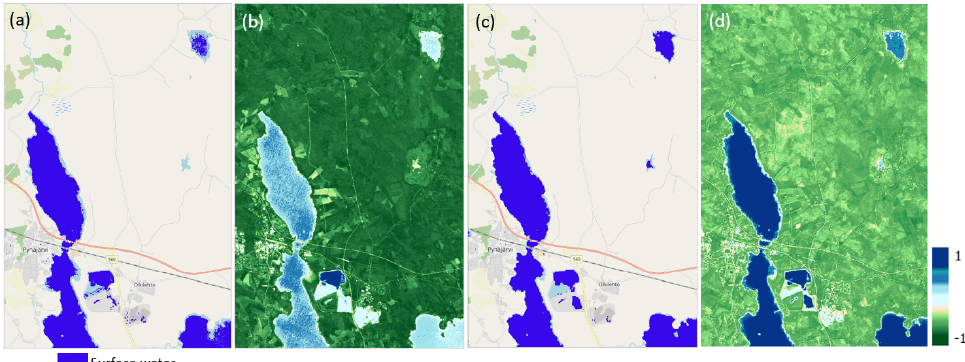
Figure 15. Optical reference masks of surface water bodies, 28 August 2021: ( a ) NDWI water map; ( b ) NDWI spectral index; ( c ) MNDWI water map; ( d ) MNDWI spectral index. Basemap: OpenStreetMap